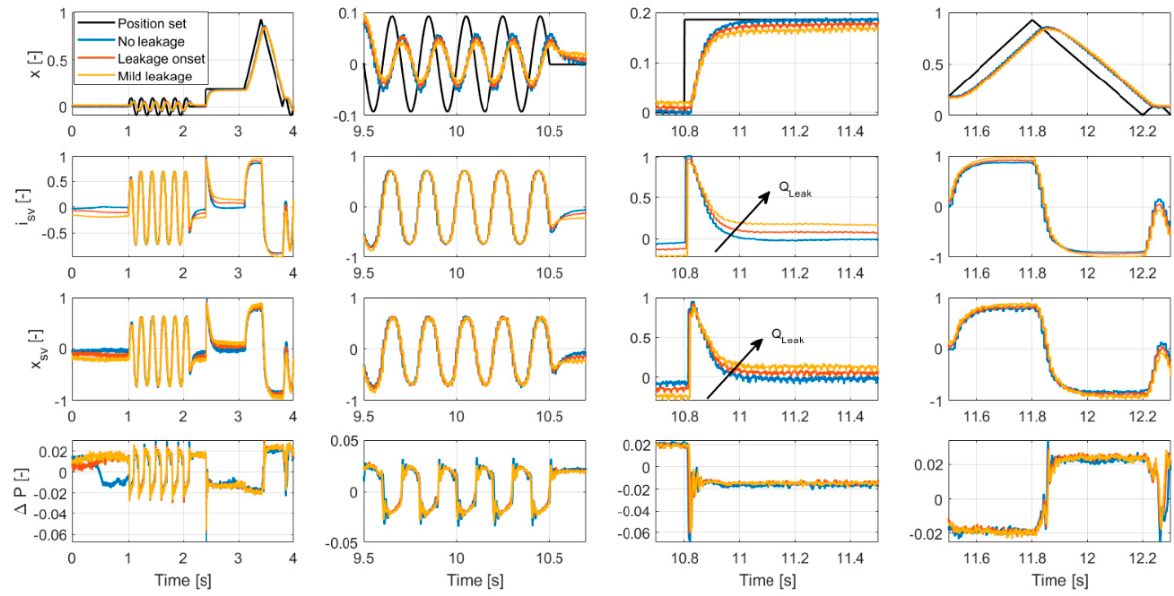
Figure 6. Results of the experimental campaign.